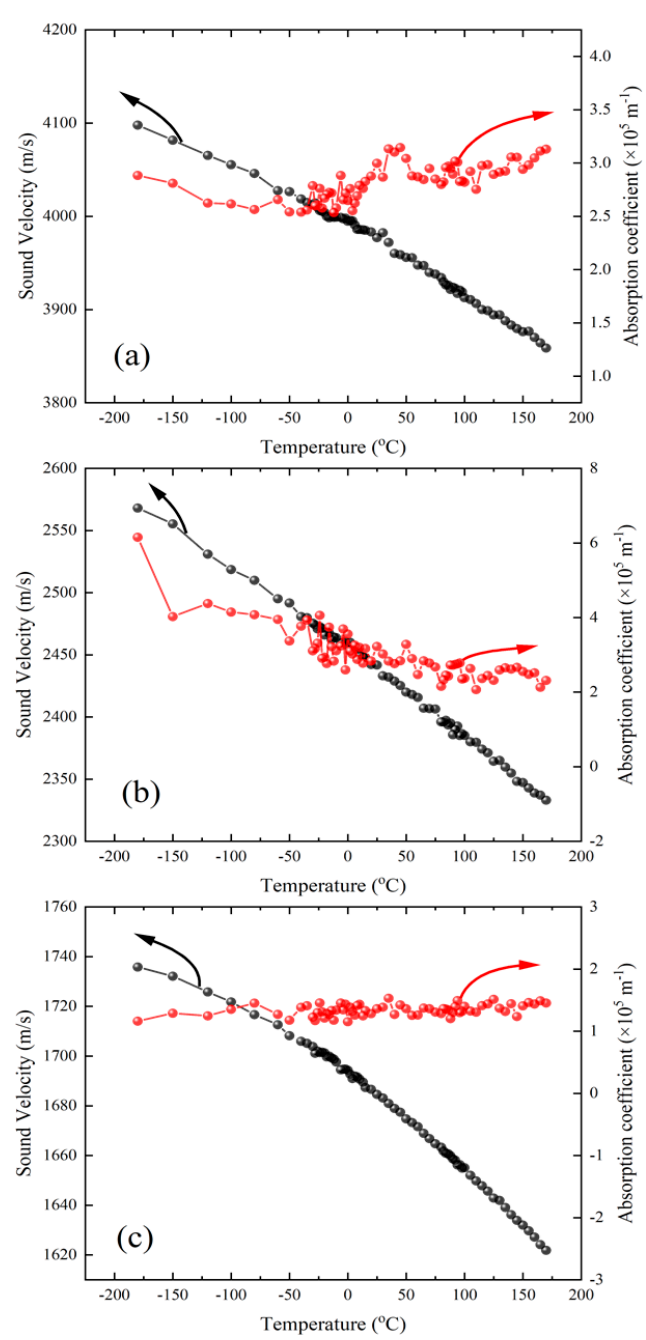
Figure 5. Temperature dependence of the sound velocity and the absorption coefficient of ( a ) the LA mode, ( b ) the TA1 mode, and ( c ) the TA2 mode.